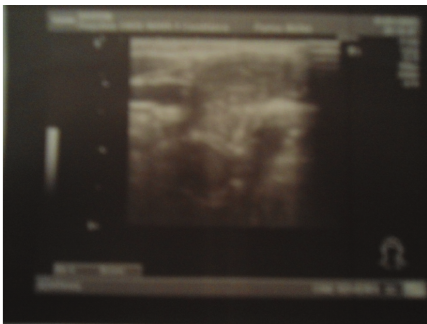
Figure 2: High resolution ultrasonography: right thyroid lobe having a hypoechoic, heterogenous.